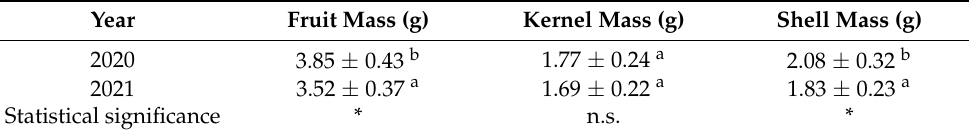
Table 2. Mass of hazelnut samples in two years of sampling.